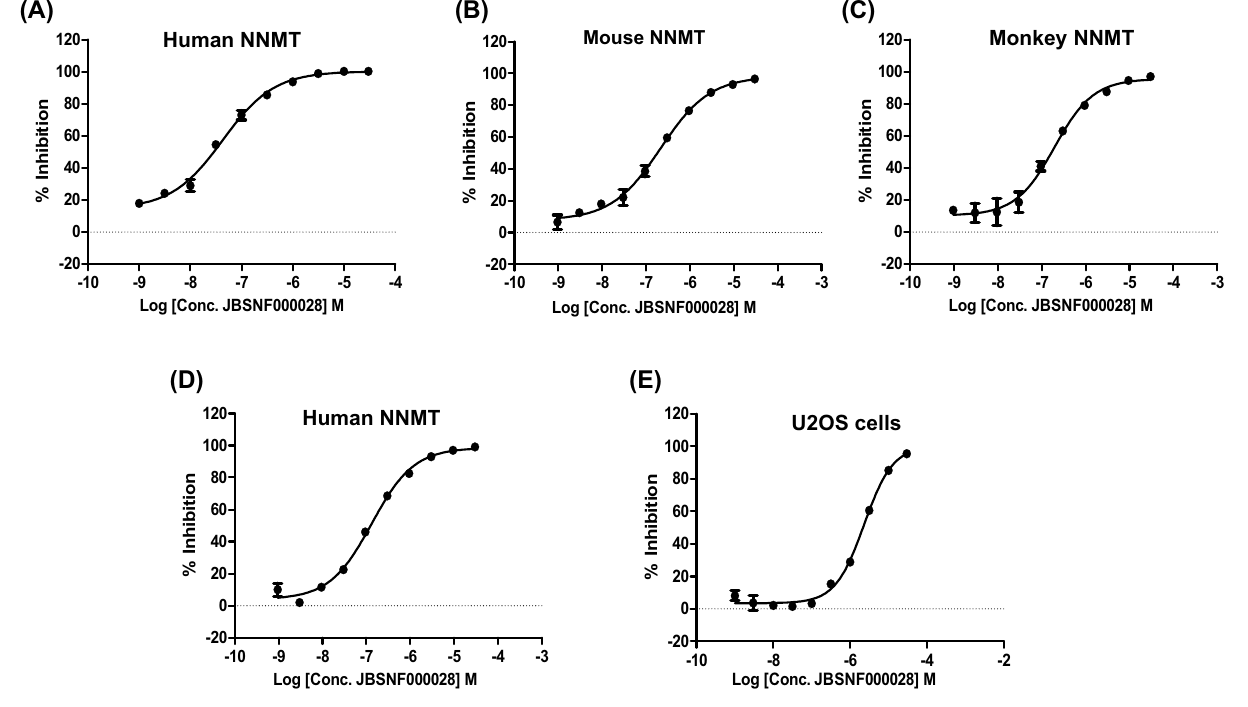
Figure 3. In-vitro activity of JBSNF-000028: Inhibition of recombinant ( A ) human, ( B ) mouse or ( C ) monkey NNMT as determined by fluorescence of an MNA derivative. ( D ) Inhibition of human NNMT as determined by LC/MS detection of MNA. ( E ) Inhibition of NNMT in U2OS cells as measured by LC/MS detection of